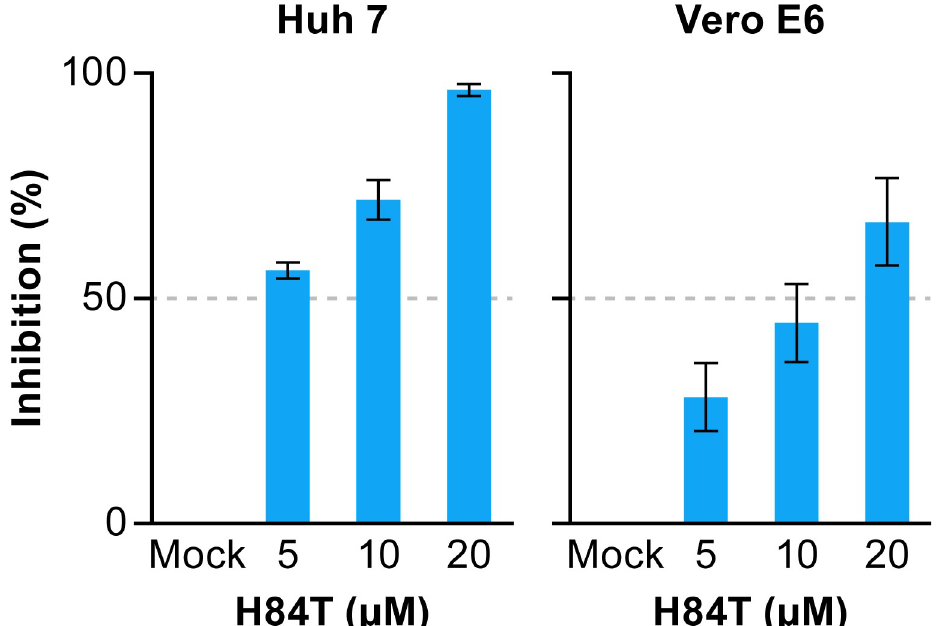
Fig 1. H84T inhibits Ebola virus infection in cell cultures. Huh 7 or Vero E6 cells were pretreated for 1 h with the indicated concentrations of H84T. Cells were infected with EBOV/Mak at an MOI of 2.5. After 48 h, cells were fixed and stained with an antibody to the EBOV VP40 protein followed by secondary staining with an Alexa 594-labeled antibody. The experiment was run on duplicate plates with triplicate wells per dose (mean ± SD; n = 3). One representative graph (from one of the two plates) is shown. Percent inhibition of infection was calculated as described in the Methods section. Abbreviations: EBOV/Mak, Ebola virus (Makona); MOI, multiplicity of infection; SD, standard deviation; VP40, viral protein